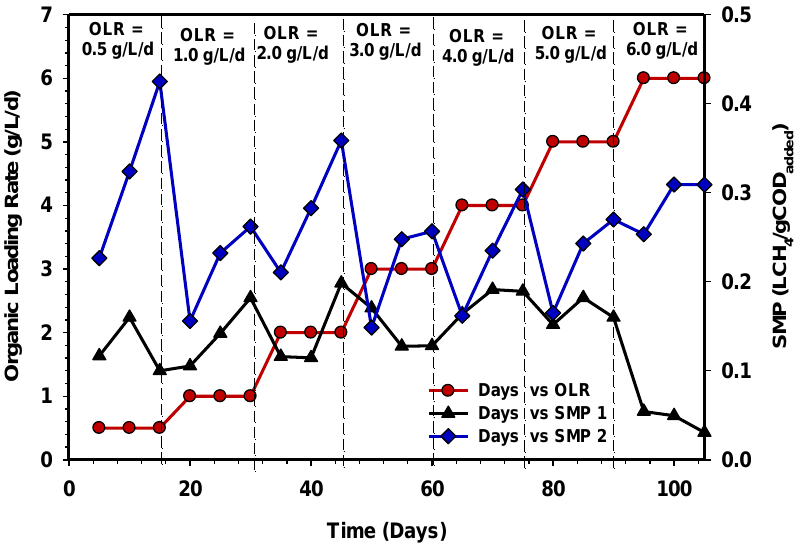
Figure 6. SMP over time in UASB 1 and 2. Figure 7 indicates the composition of methane gas concentration over a period of operation of UASB 1 and 2. It is clear that the dramatic drop in UASB 1 methane concentration was due to the shock the systems received as a result of the increases in OLR, which substantially harmed the methanogenic activity.